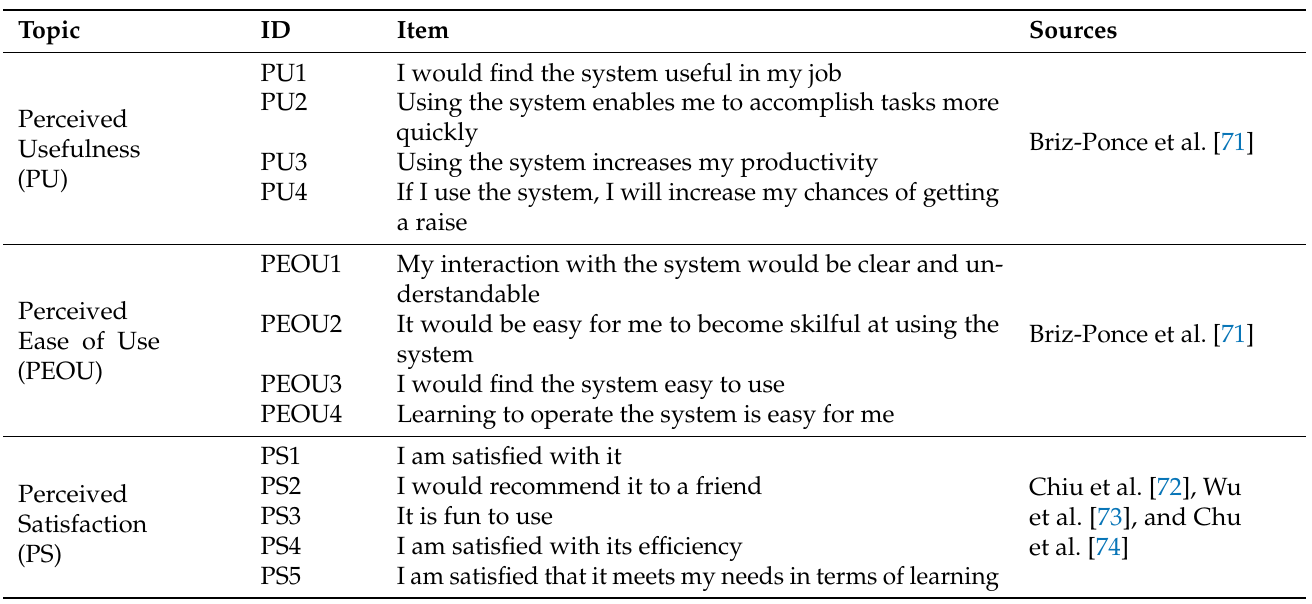
Table 1. Survey implemented in this